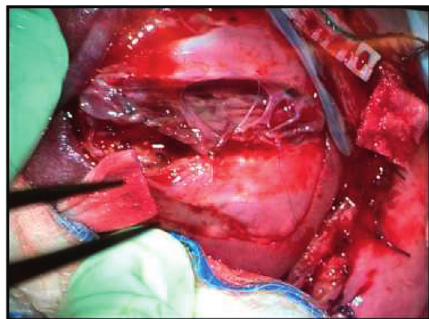
Figure 1: Myelomeningocele defect 5 × 5cm associated with a kyphotic deformity and exposed neural tissue. Closure involved sewing in a skin patch over the